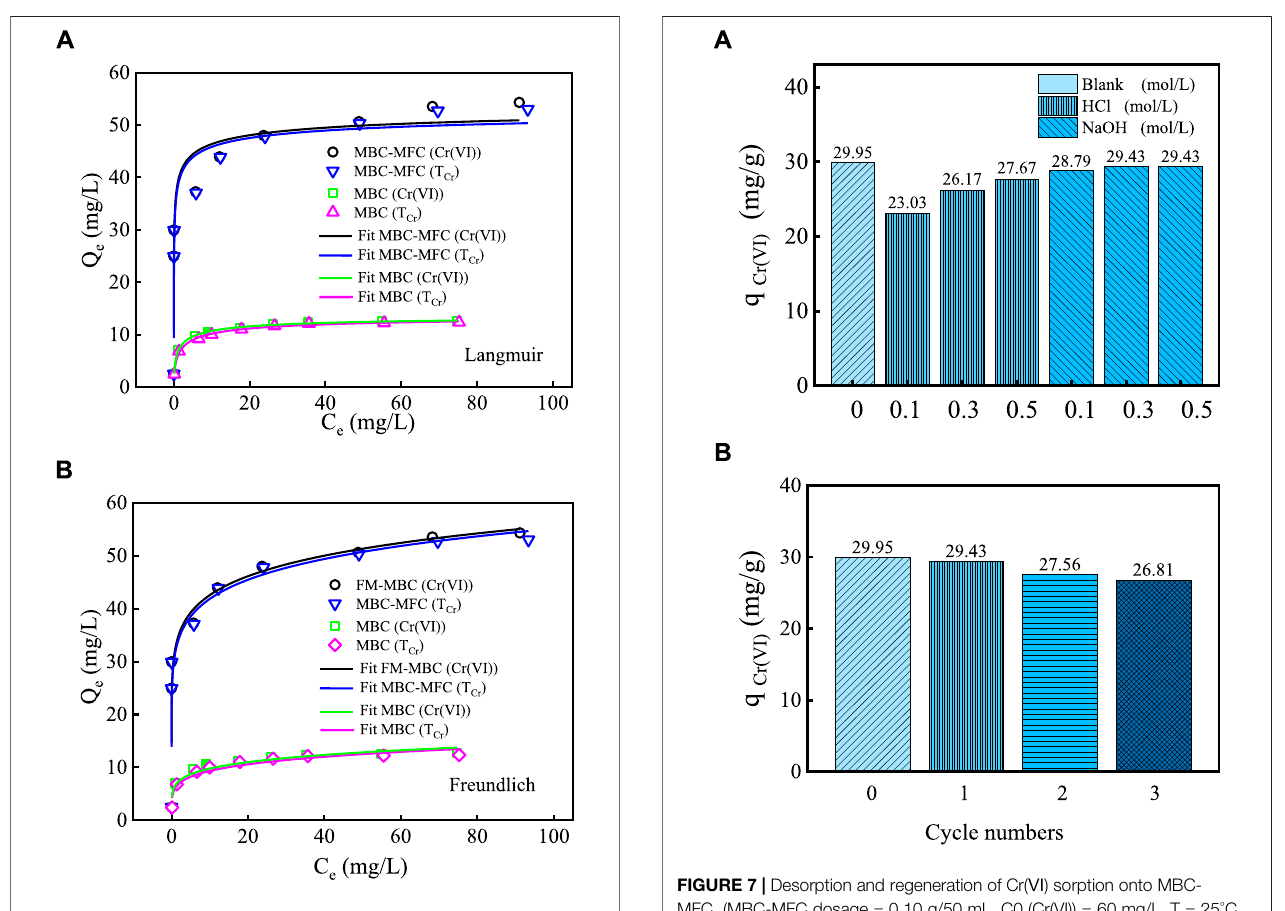
FIGURE6| TheCr(VI)andT Cr removalisotherm fi ttedwithLangmuirand Freundlich ( T (cid:1) 25 ° C; pH (cid:1) 3.0). (A) Langmuir. (B) Freundlich.